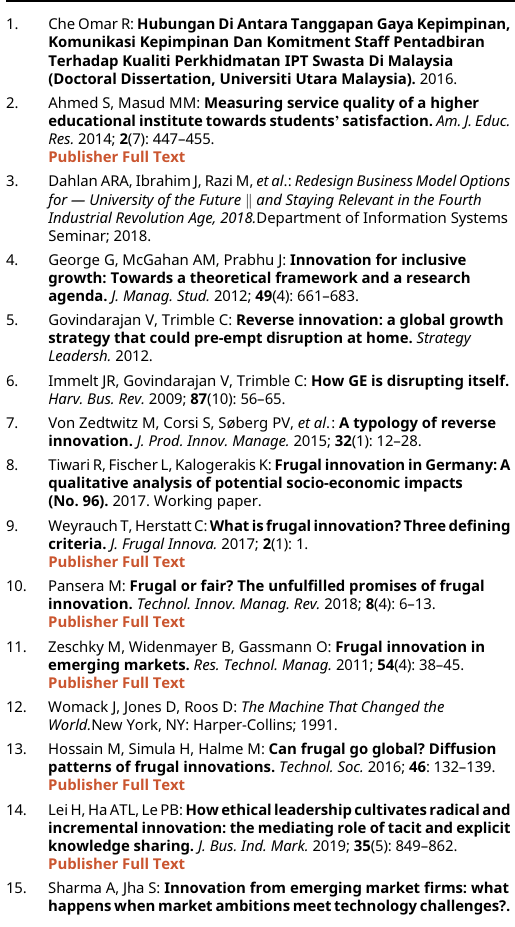
Data are available under the terms of the Creative Commons Attribution 4.0 International license (CC-BY